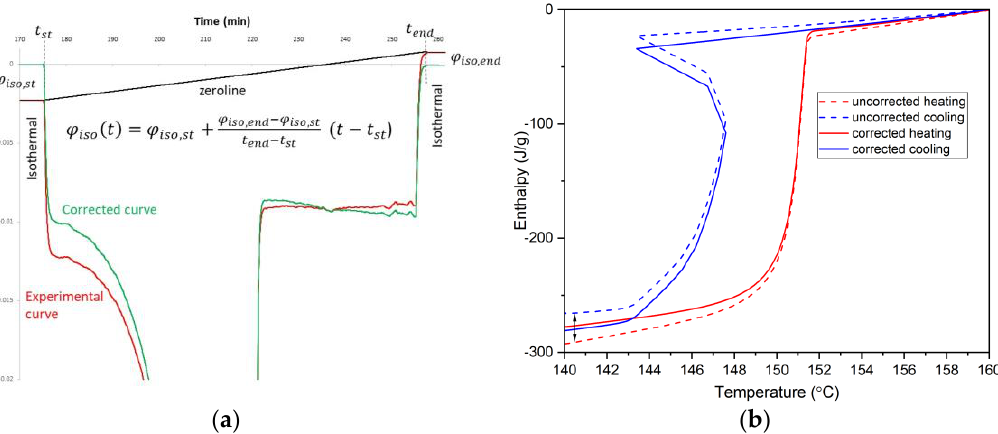
Figure 12. Schematic of the IEA method using personal data with adipic acid (personal data).